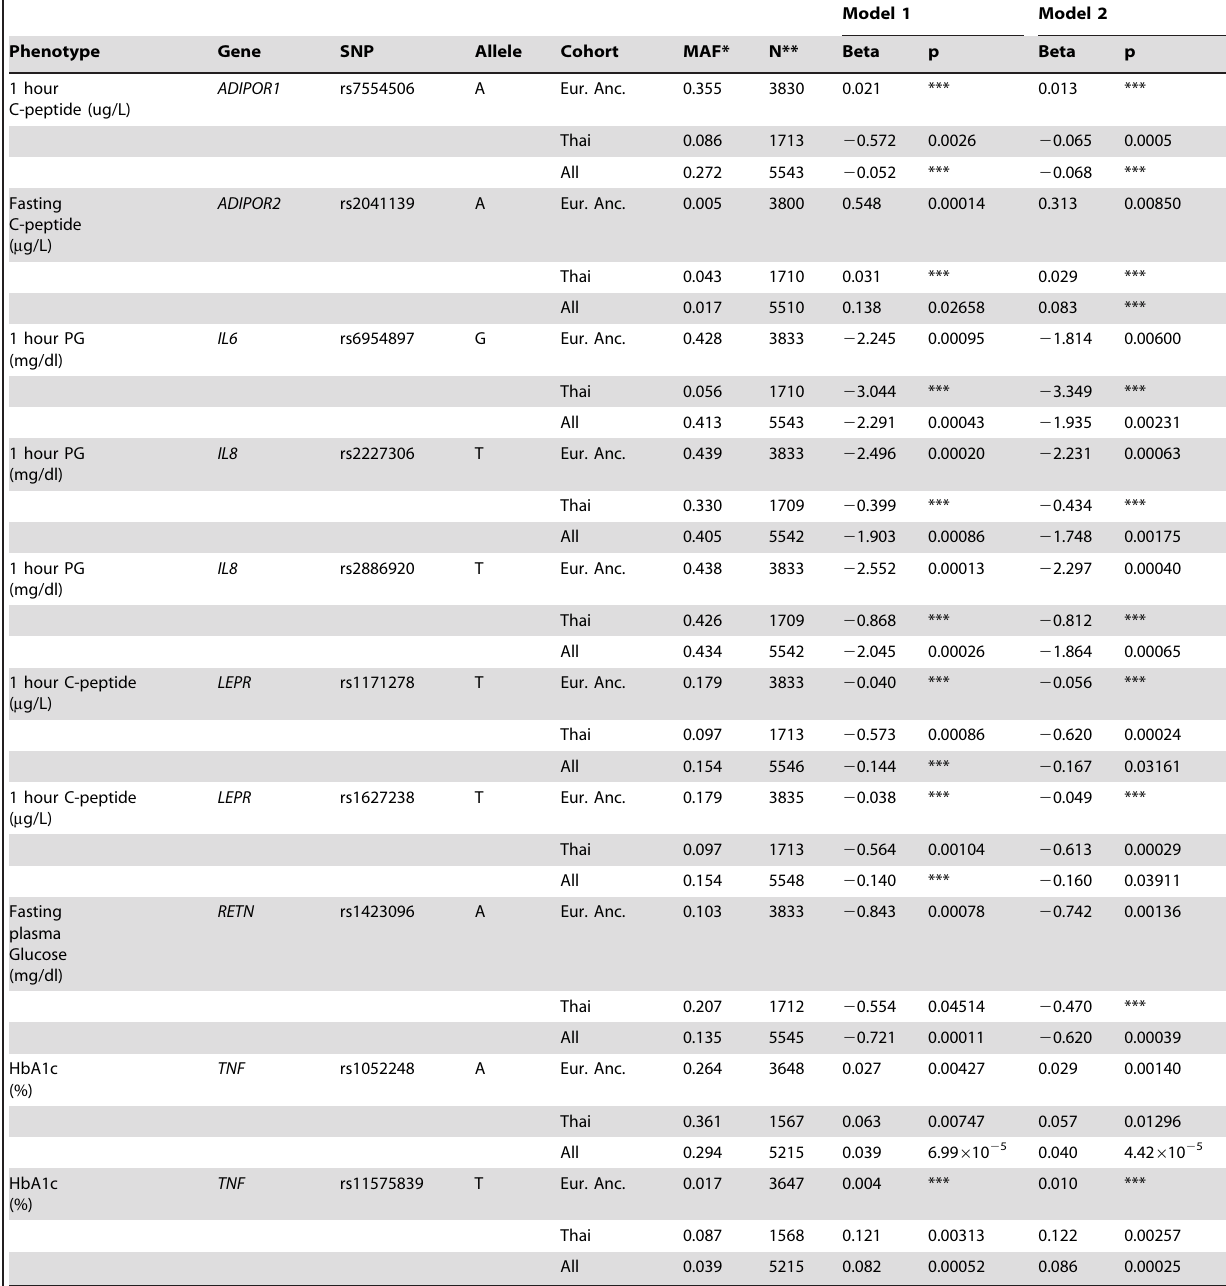
Table 4. Results of Association